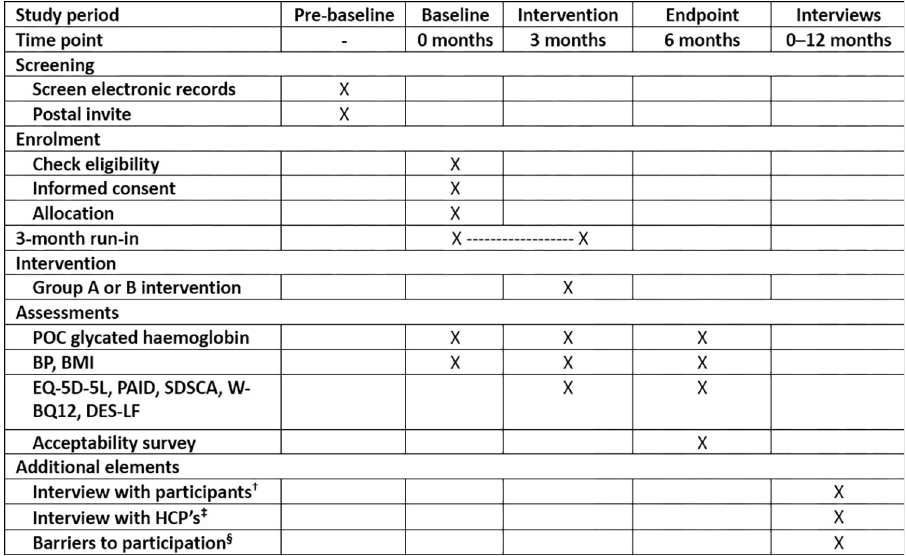
Fig 1. Schedule of procedures and assessments. POC: point-of-care; HbA1c: glycated haemoglobin; BP: blood pressure; BMI: body mass index; EQ-5D-5L: EuroQoL-5D-5L; PAID: Problem Areas in Diabetes; SDSCA: Summary of Diabetes Self-care Activities; W-BQ12: Well-being Questionnaire-12; DES-LF: Diabetes Empowerment Scale-Long Form; HCP: Healthcare Professional; mmol/mol: millimoles per mole, glycated haemoglobin SI unit of measurement. † Sub-study B. Semi-structured interviews in those enrolled in sub-study A. ‡ Sub-study C. Semi-structured interviews with healthcare professionals. § Sub-study D. In those declining to take part in sub-study A, survey and semi- structured